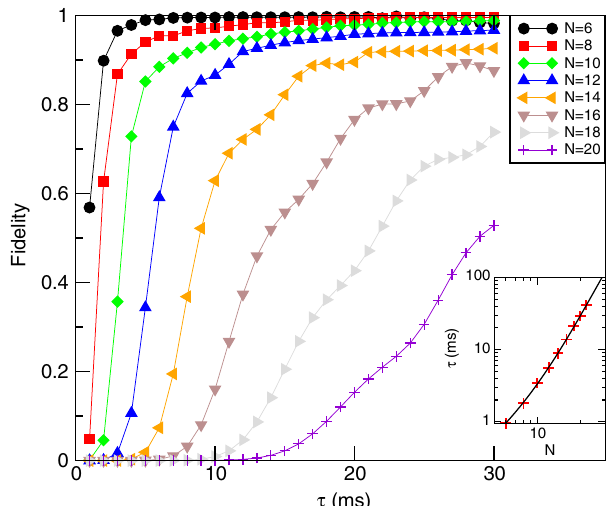
Figure 6 | Fidelity estimates of the quantum annealing and scaling of annealing times. We solve the equations of motion, equation (12), for a glassy instance at different system sizes N , and plot the fidelity of the outcome as a function of the annealing time t . In the inset, we investigate the scaling behaviour by plotting (in double-logarithmic scale) the value of t which is needed for a fidelity F ¼ 0.5 as a function of N . A fourth-order polynomial fit agrees very well with the data (black dashed line). The fit parameters, as defined by equation (13), are t 0 ¼ 90 (cid:10) 40 ð Þ ms and g ¼ 12.0 ± 1.2. For all calculations, we have chosen a beatnote frequency between the two lowest resonances, o L ¼ 0.8 o 1 þ 0.2 o 2 , a trap frequency o z ¼ 2 p (cid:2) 270kHz, and a bias potential E ¼(cid:3) 1kHz. The initial value of the transverse field was B max ¼ 10kHz.